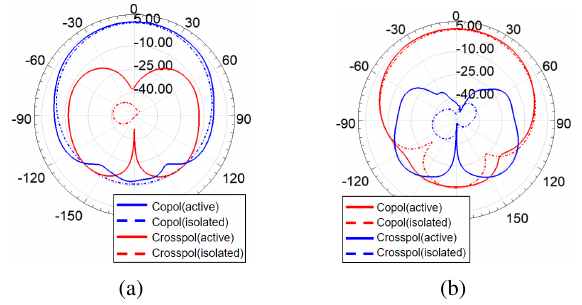
FIGURE 11: Active element patterns and isolated element patterns for (a) H and (b) V-polarization